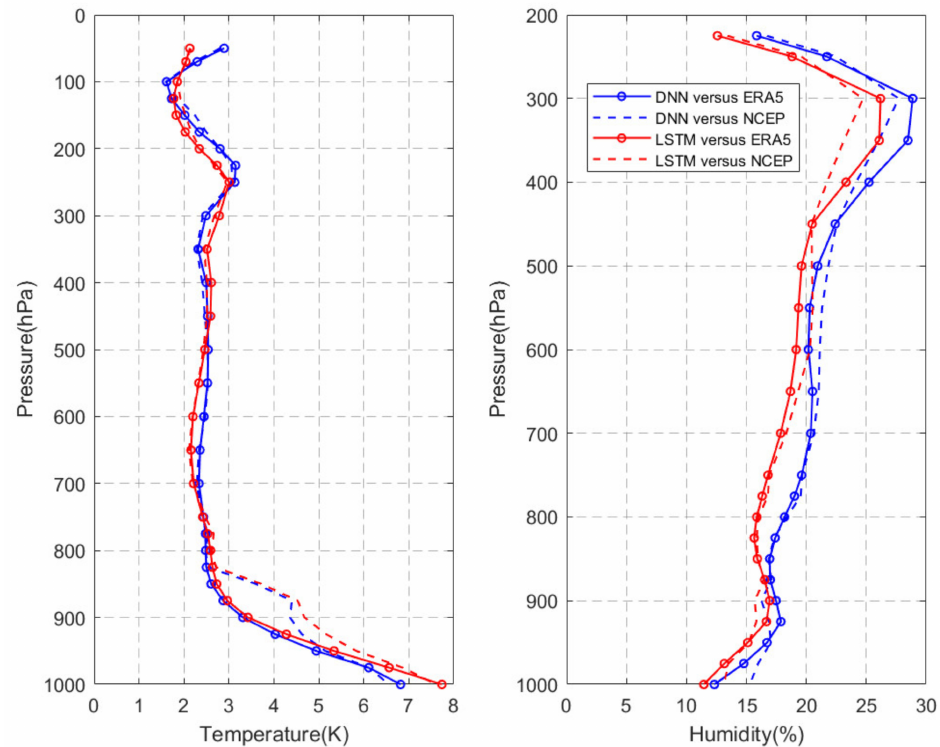
Figure 10. The retrieval RMSEs of the DNN-based model and the LSTM-based model with respect to the ERA5 and NCEP reanalysis data over land in February